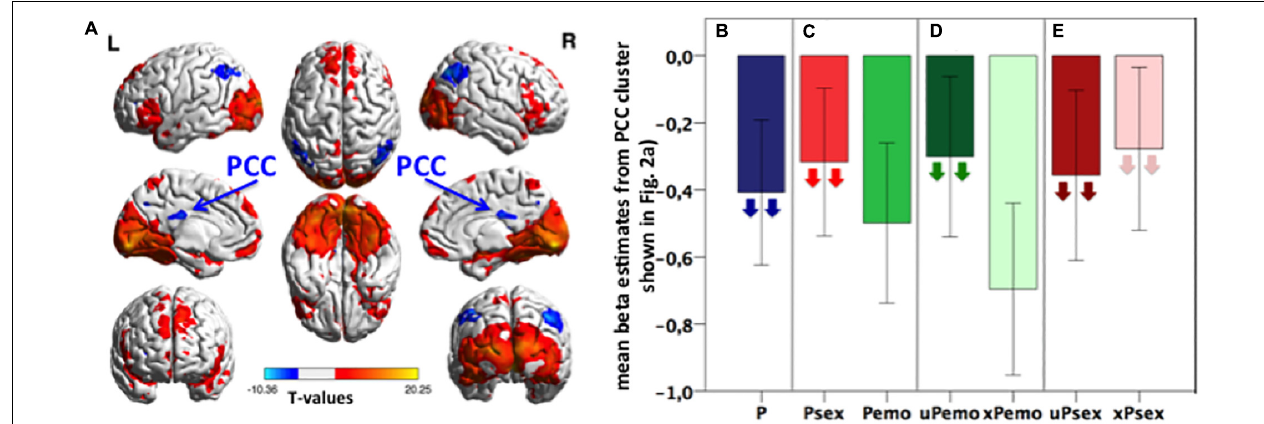
FIGURE 1 | (A) Task activation of the contrast P > fix. Blue color represents deactivation clusters, red color depicts activation clusters. Displayed with BrainNet Viewer (Xia et al., 2013), p < 0.05 FWE, cluster level corrected, with initial threshold p < 0.001, k size > 191, n = 31 subjects. (B–E) Bar plots: Extracted mean beta estimates from the PCC correlation cluster (light blue and yellow shown in Figure 2A ) for all picture conditions and subconditions versus fixation, showing differential deactivation. Down-pointing arrows in subconditions indicate negative correlation with the Glu/tCr level in dACC. Higher Glu/tCr in the dACC, more deactivation during certain condition is present. Data is presented in mean ± standard error of the mean (SEM), n = 31. P, all expected and unexpected emotional and sexual pictures; Psex, expected and unexpected sexual pictures; Pemo, expected and unexpected emotional pictures; uPemo, unexpected emotional pictures; xPemo, expected emotional pictures; uPsex, unexpected sexual pictures; xPsex, expected sexual pictures.